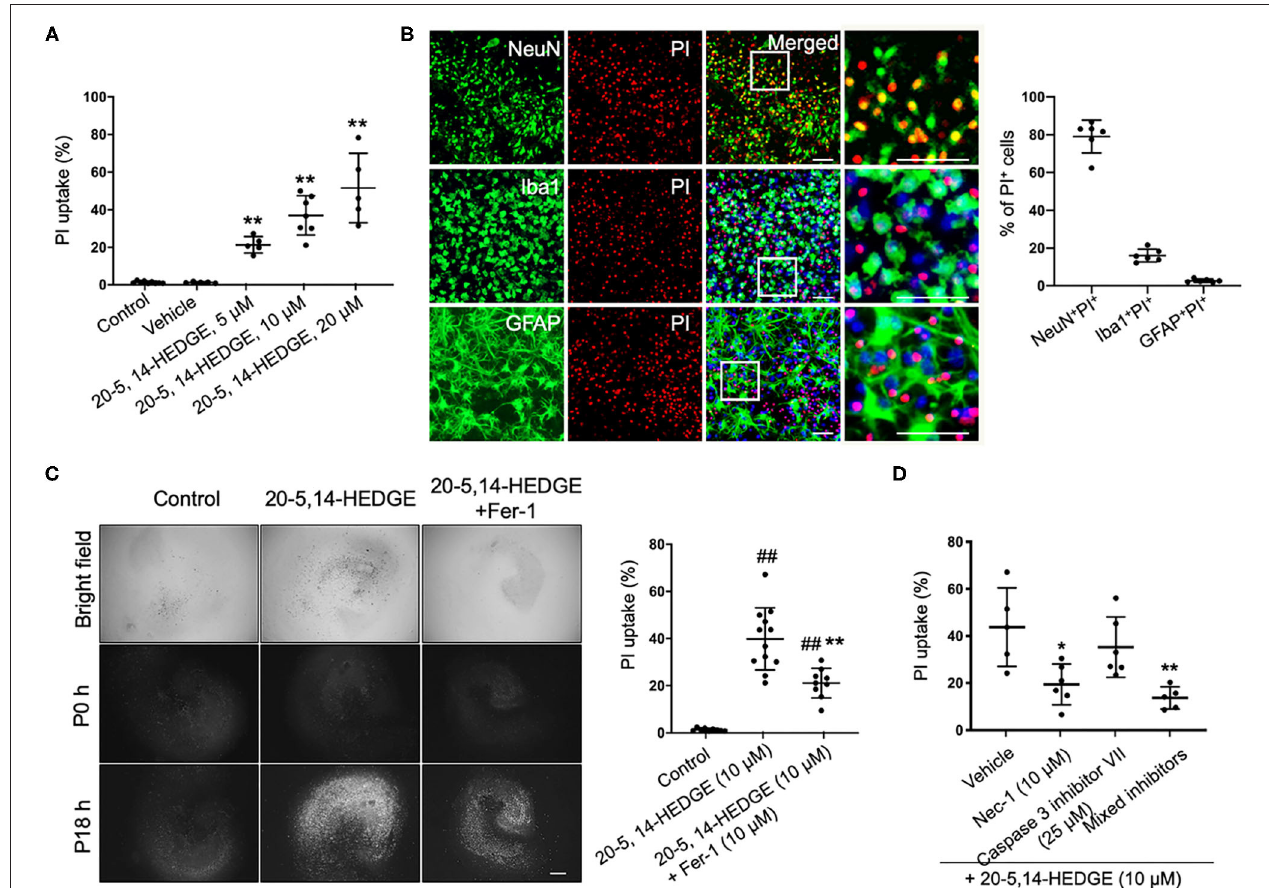
FIGURE 3 | 20-HETE–induced cell death is mitigated by inhibiting ferroptosis. (A) The stable 20-HETE mimetic 20-5,14-HEDGE at indicated concentrations or vehicle was added to organotypic hippocampal slice cultures (OHSCs), and cell death was assessed by PI staining 18h later. All three doses of 20-5,14-HEDGE induced significant cell death. The dose of 10 µ M was chosen for subsequent experiments because it produced cell death similar to that produced by Hb. n = 5–9 slices/group. (B) Fixed slices were immunostained with NeuN, Iba1, and GFAP (green) to assess the distribution of neurons, microglia, and astrocytes among PI-labeled dead cells. The percentage of PI + neurons (PI + NeuN + ) was more than PI + microglia (PI + Iba1 + ) and PI + astrocytes (PI + GFAP + ). Bar is 50 µ m. n = 6 slices/group. (C) The effect of ferrostatin-1 (Fer-1; 10 µ M) on 20-5,14-HEDGE-induced cell death was measured by PI staining. Fer-1 significantly alleviated 20-HETE mimetic-induced cell death. Bar is 500 µ m. n = 9–12 slices/group. (D) Effect of cell death inhibitors caspase 3 inhibitor VII (apoptosis inhibitor, 25 µ M), necrostatin-1 (Nec-1, necroptosis inhibitor, 10 µ M), and a combination of Fer-1, caspase 3 inhibitor, and Nec-1 on 20-5,14-HEDGE–induced cell death was assessed by PI staining. n = 5–6 slices/group. * P < 0.05, ** P < 0.01 vs. 20-5,14-HEDGE Vehicle group; ## P < 0.01 vs. Control group. One-way ANOVA followed by appropriate post-hoc test was applied. Data are expressed as mean ±